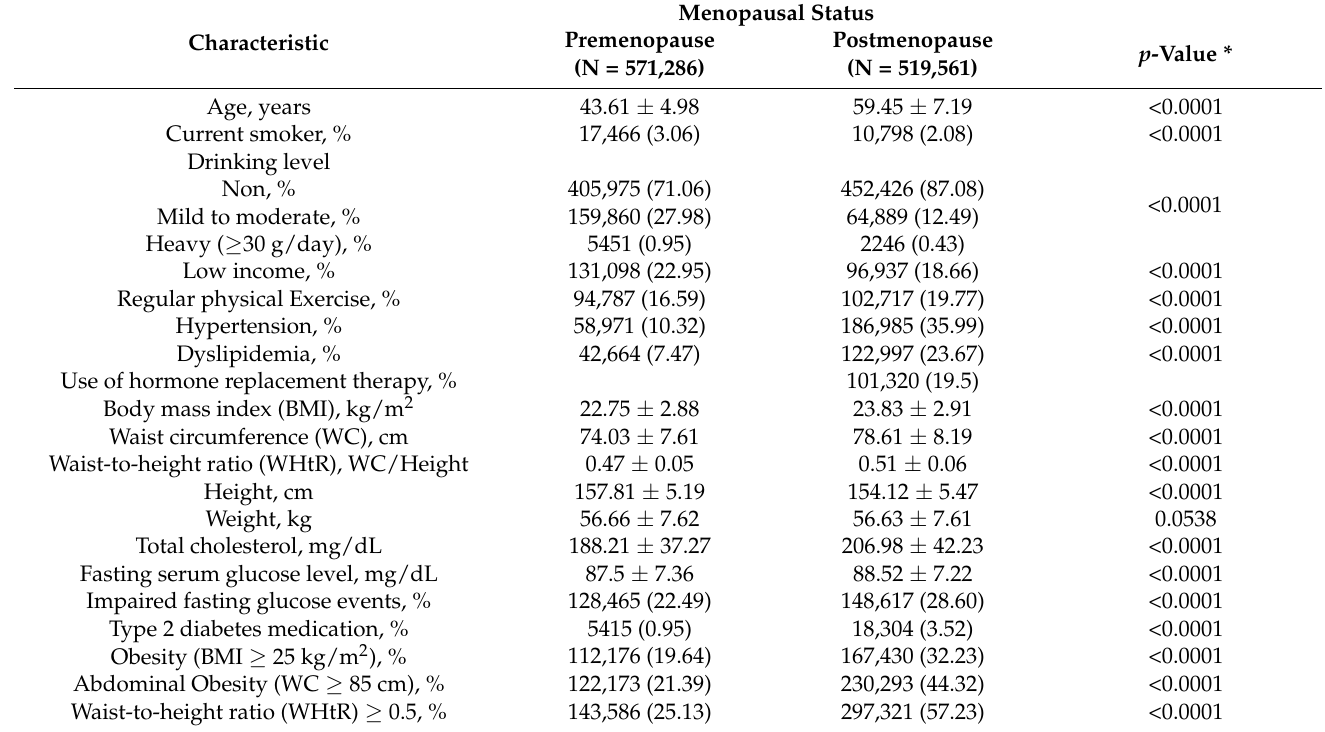
Table 1. Baseline characteristics according to menopausal